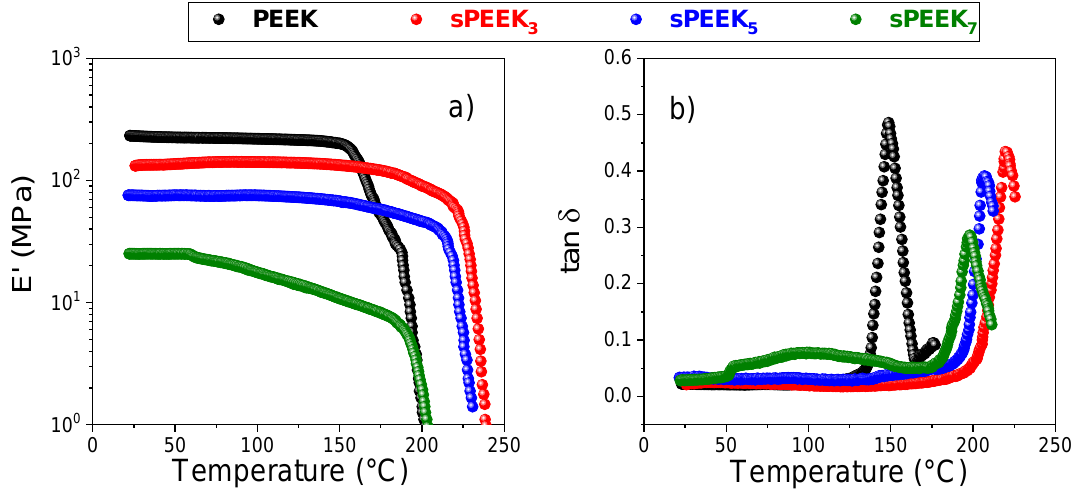
Figure 2. Temperature evolution of the storage moduli ( a ) and dumping factor ( b ) of PEEK and sPEEK membranes at different sulfonation degrees.